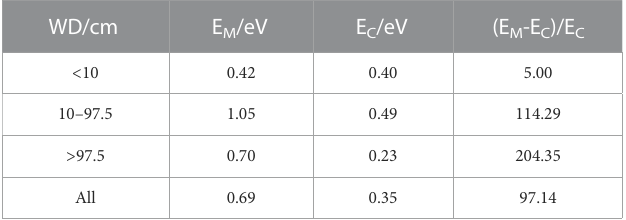
TABLE 2 Temperature dependence of CH 4 and CO 2 in WD